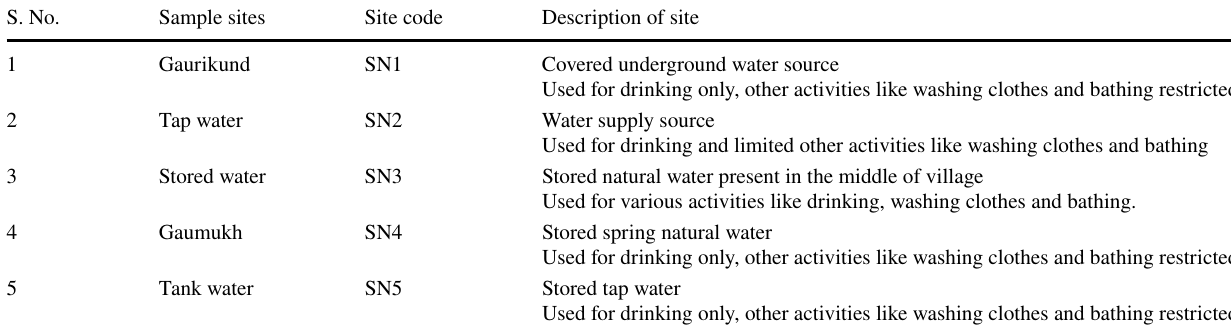
Table 1 Detail of sampling sites S.